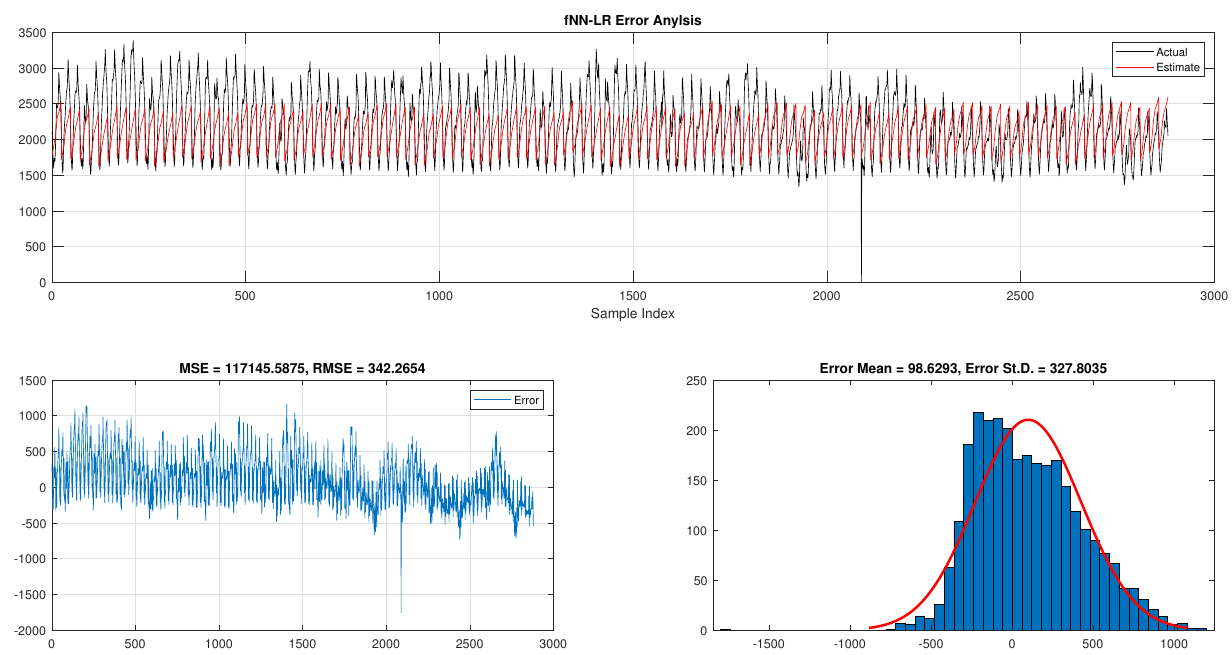
Figure 6. Error analysis of the hourly daily load consumption with LR best results.